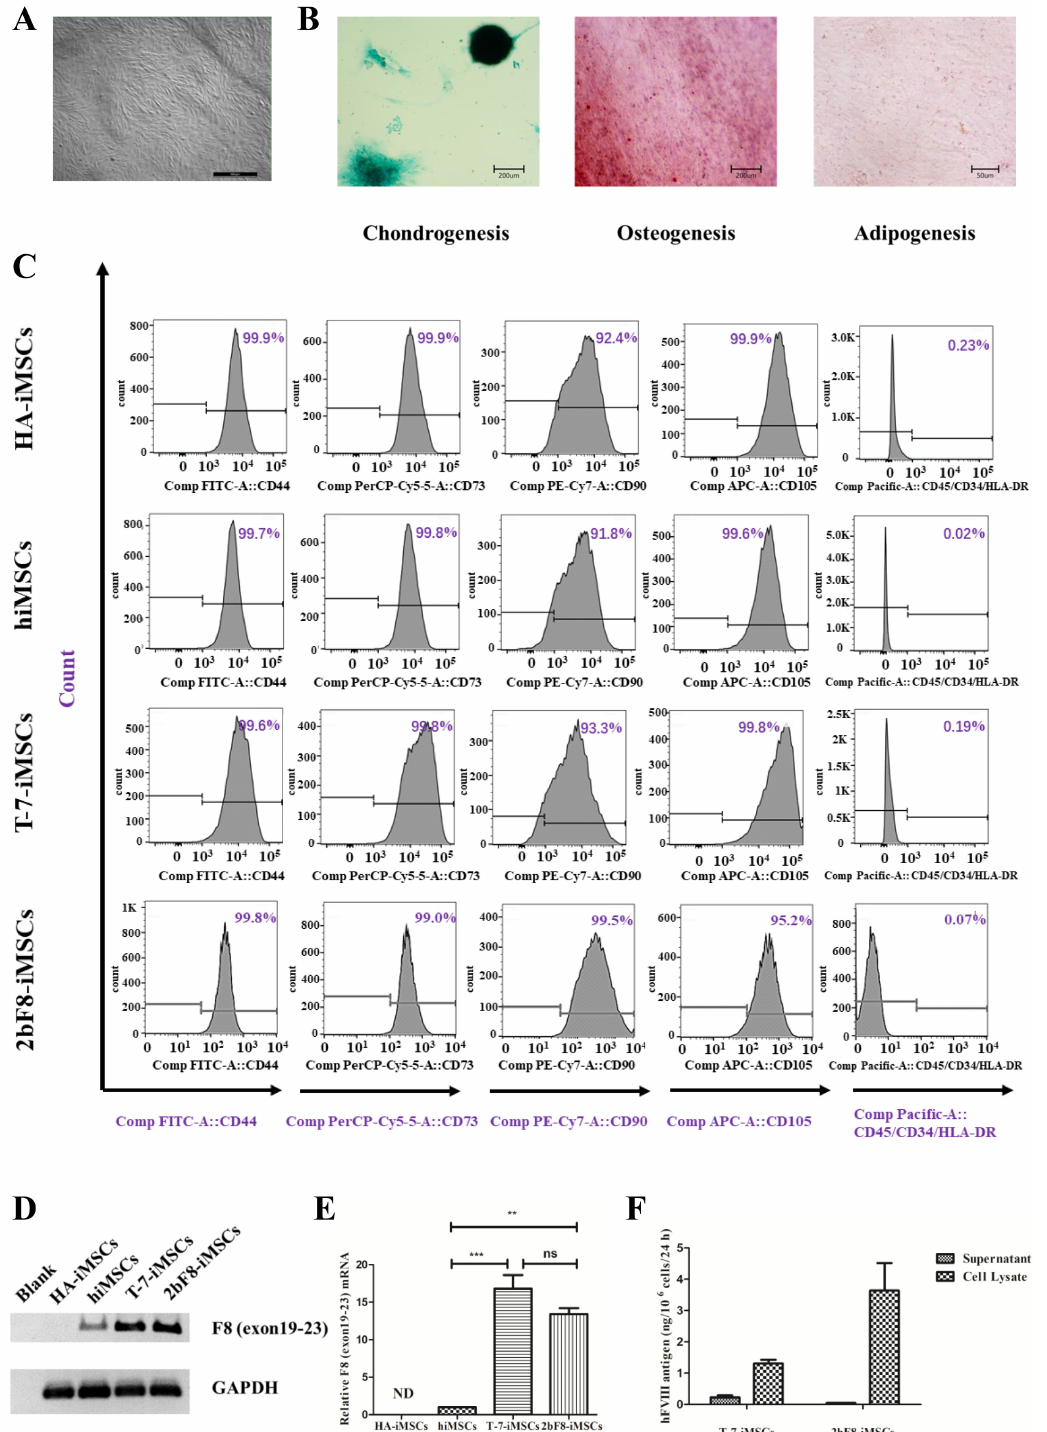
and 2bF8-iHPCs was detected by qRT-PCR. GAPDH was used as the internal reference. ND, not detected. ** p < 0.01. Bars represent the mean ± SEM ( n = 3, each group). ( E ) FVIII antigen in the supernatant and cell lysate of HA-iHPCs, hiHPCs, and 2bF8-iHPCs was examined by ELISA. Data represent the mean ± SEM ( n = 3, independent cultures).